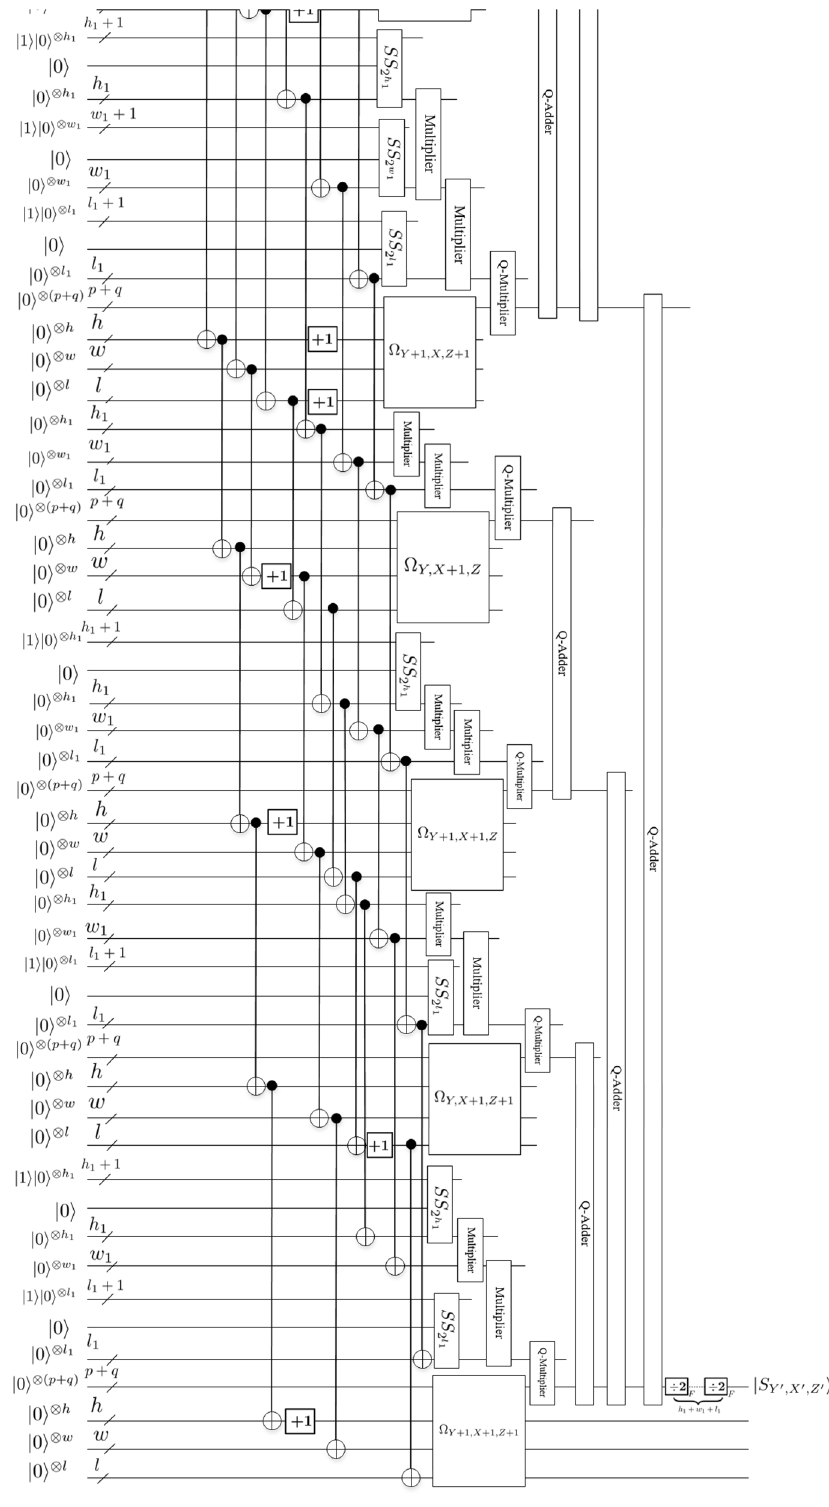
Figure 18. Scaling-up